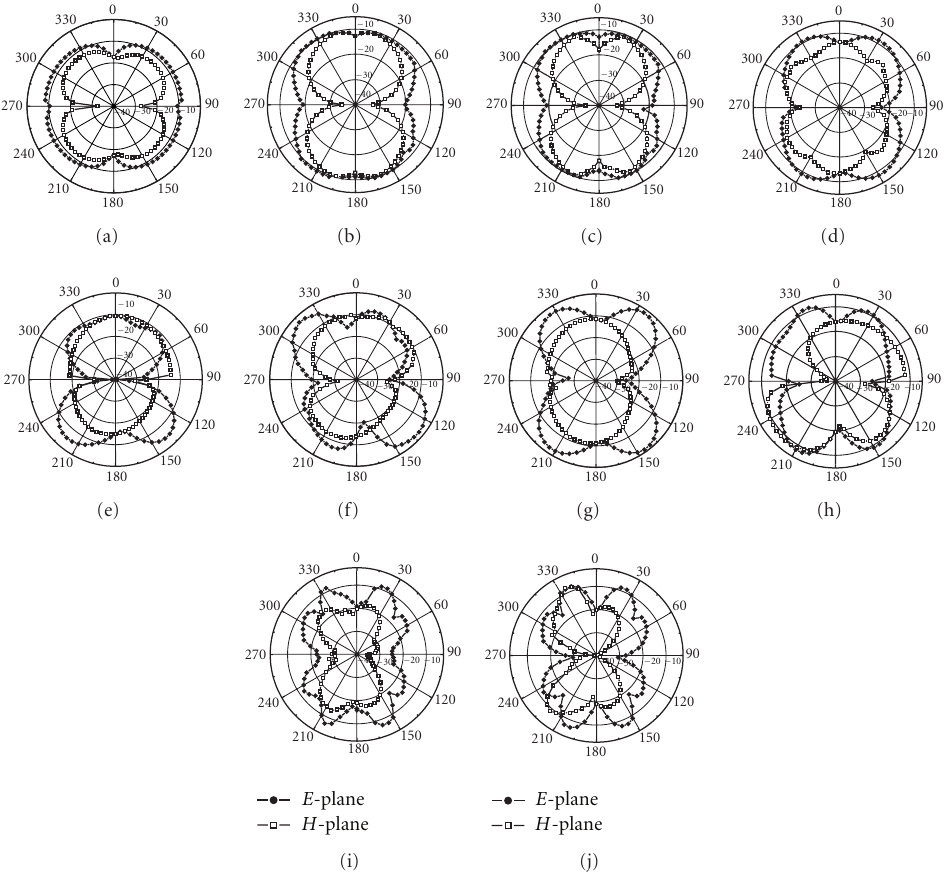
Figure 11: Measured radiation patterns of the proposed antenna—(a) f = 1 . 95 GHz, (b) f = 2 . 4GHz, (c) f = 3 . 5 GHz, (d) f = 4 . 5 GHz, (e) f = 5 . 5 GHz, (f) f = 6 . 5 GHz, (g) f = 7 . 5GHz, (h) f = 8 . 8 GHz, (i) f = 9 . 5 GHz, and (j) f = 10 . 4 GHz.